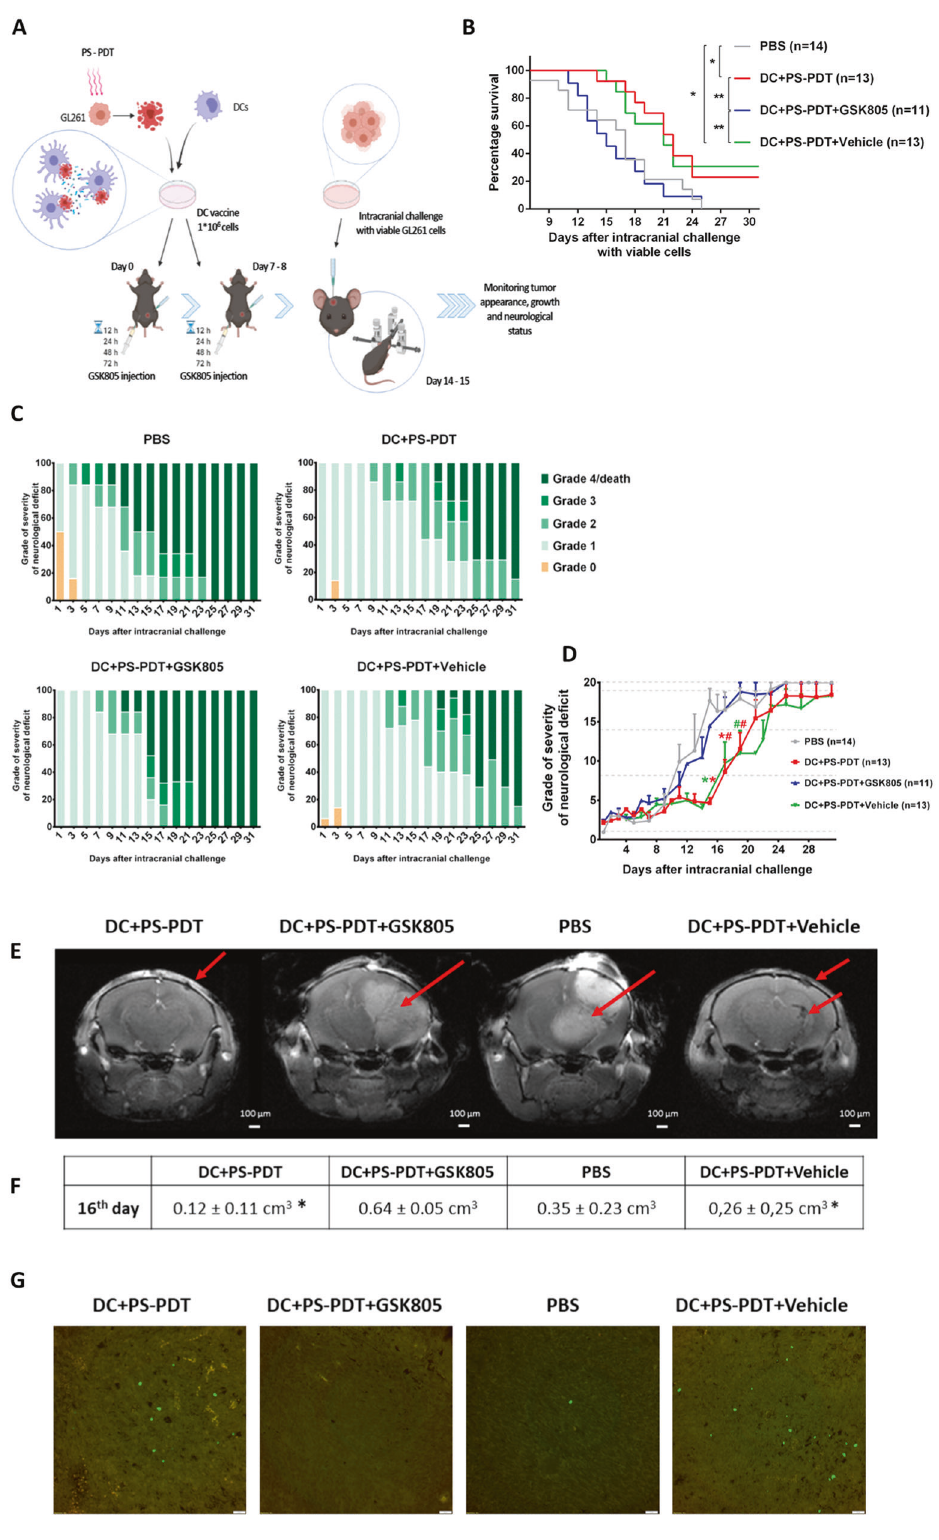
Next, the distribution of risk score, survival status, and the heatmap of prognostic gene expression in the CGGA-LGG dataset were analyzed (Fig. 7A – C). Consistent with the results of the TCGA- LGG dataset, the Kaplan – Meier survival curves and log-rank test ( p -value = 9.28e − 07) revealed a signi fi cant difference in overall